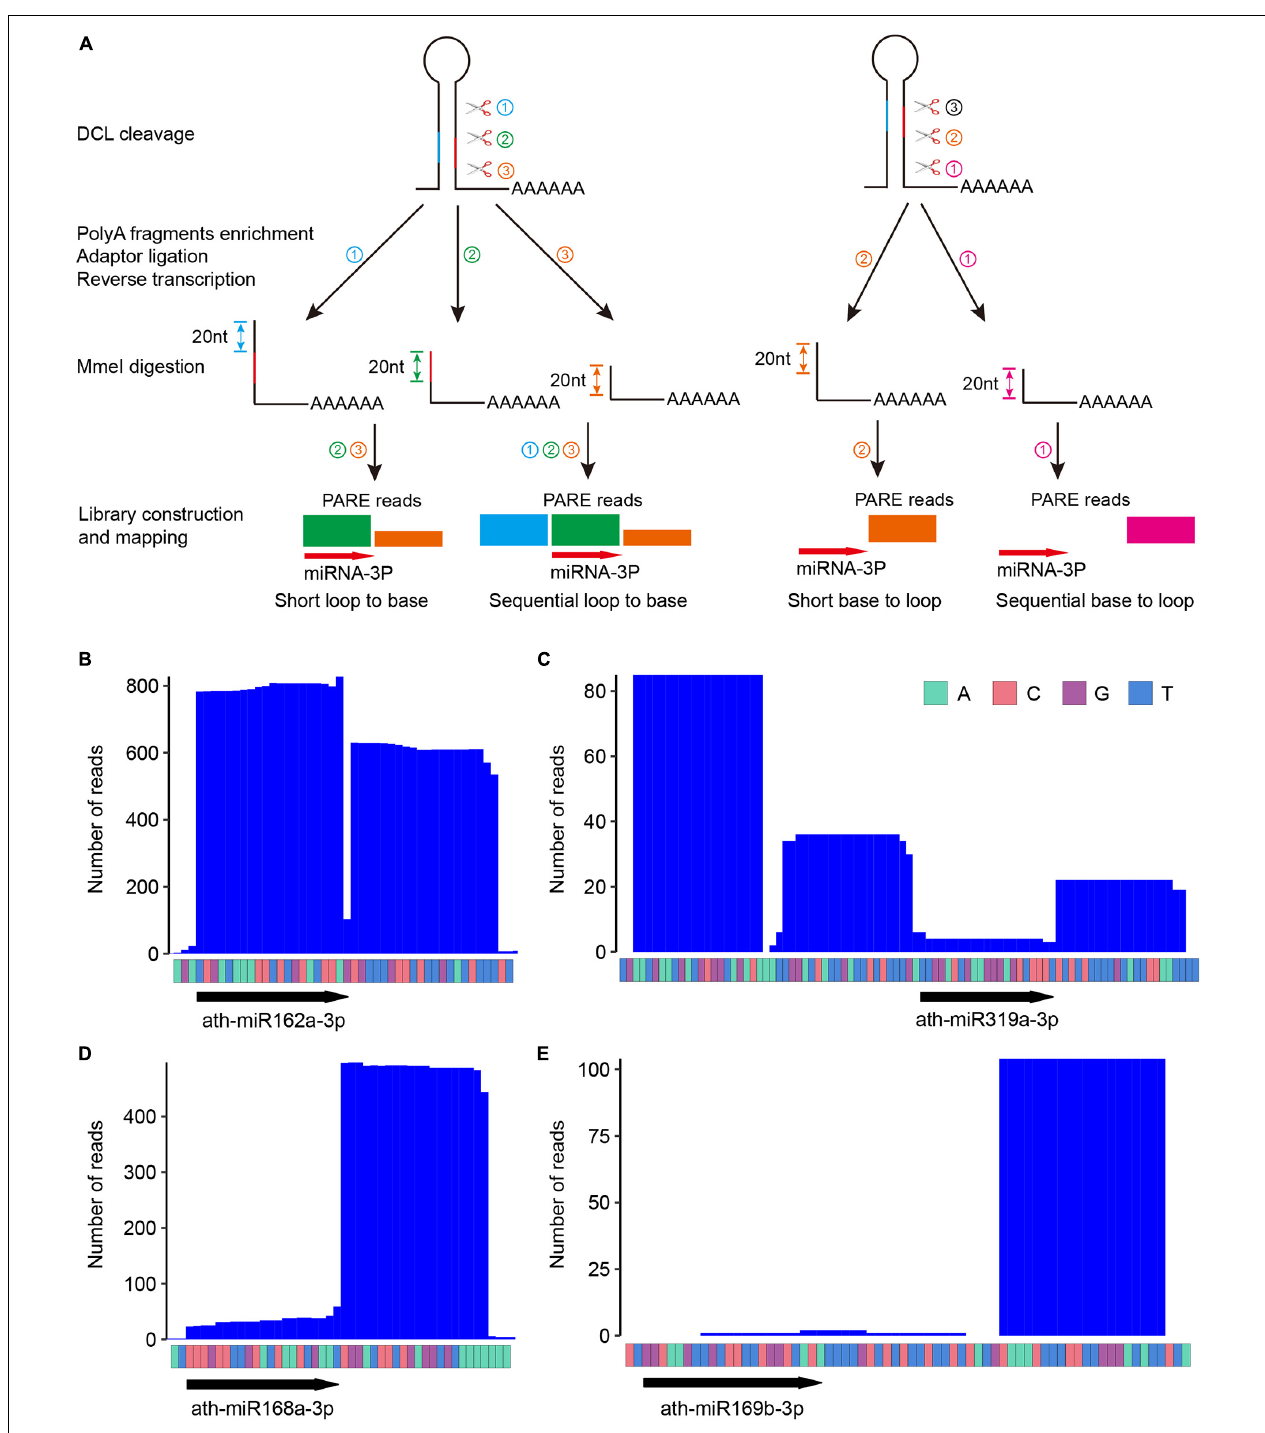
FIGURE 1 | Parallel Amplification of RNA Ends (PARE) patterns reflect different miRNA processing modes. (A) Schematic diagram of PARE library construction and typical PARE patterns for different miRNA processing modes. (cid:192)(cid:193)(cid:194) depicts the order of cleavage. Note that for short loop-to-base processing, only two cuts (i.e., (cid:193)(cid:194) ) are executed, and for sequential processing, additional cuts (i.e., more than three cuts) may occur but are not shown here. Different colors of PARE signals reflects their sources of cleavage remnants. Bottom arrow highlights the position of miR-3p. (B–E) Degradome profiles of four selected miRNAs with known processing modes. ath-miR162a (B) , short loop to base; ath-miR319a (C) , sequential loop to base; ath-miR168a (D) , short base to loop; ath-miR169b (E) , sequential base to loop. Raw counts from four representative datasets with high abundance at respective analyzed miRNA locus (miR162a, SRR1171803; miR319a, SRR7652709; miR168a, SRR1171802, ath-miR169b, SRR7652709) were used for plotting the figures.